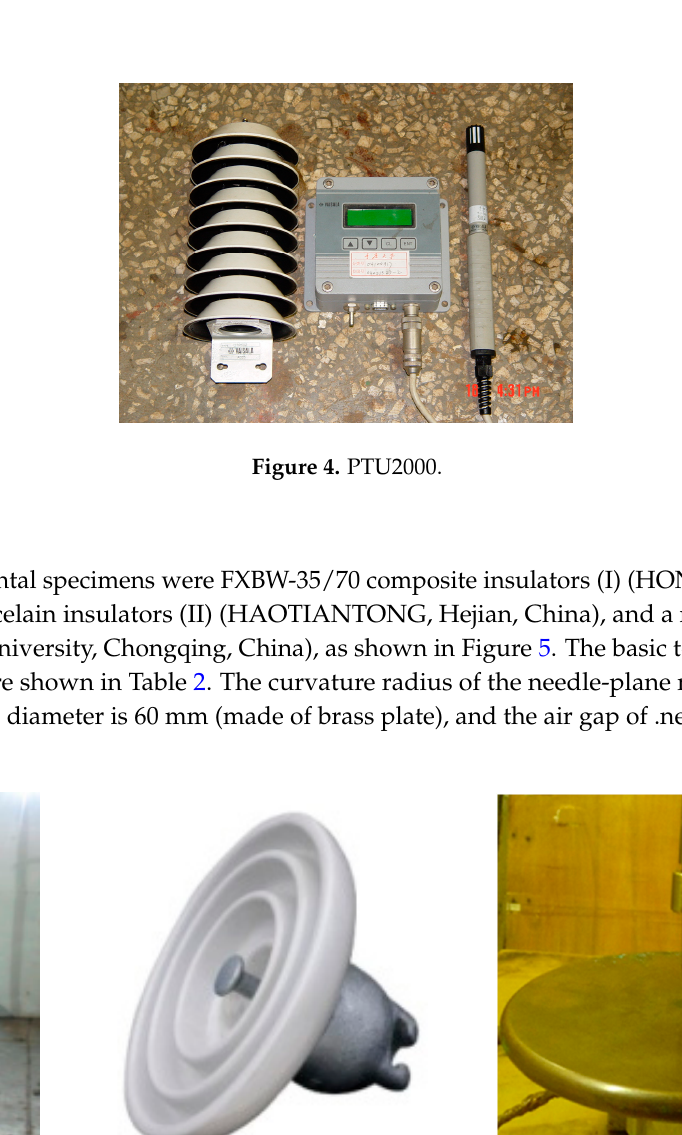
HUV Camera Figure 2. Schematic of the test circuit. T: 10 kV voltage regulator; B: testing AC transformer; R1, Rm: protective resistance; F: AC capacitive voltage divider (10,000:1); R2: detection impedance; H: oscilloscope. DayCor ® Superb (Type A, made by OFIL, Tel Aviv ‐ Yafo, Israel) and CoroCAM ® 6d (Type B, made by CSIR, Cape Town, South Africa) UV imagers were used in the experiments, as shown in Figure 3. The basic parameters of the UV imagers are shown in Table 1. ( a ) ( b ) Figure 3. Ultraviolet (UV) imagers. ( a ) Type A; ( b ) Type B. Table 1. Basic parameters of the ultraviolet (UV) imagers. Type